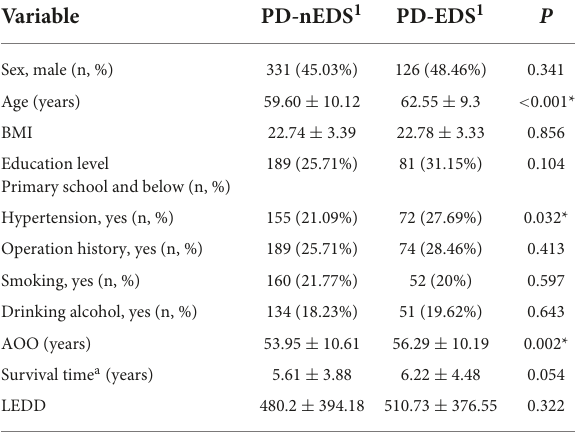
TABLE 1 Comparison of basic conditions between the PD-EDS 1 and PD-nEDS 1 groups.